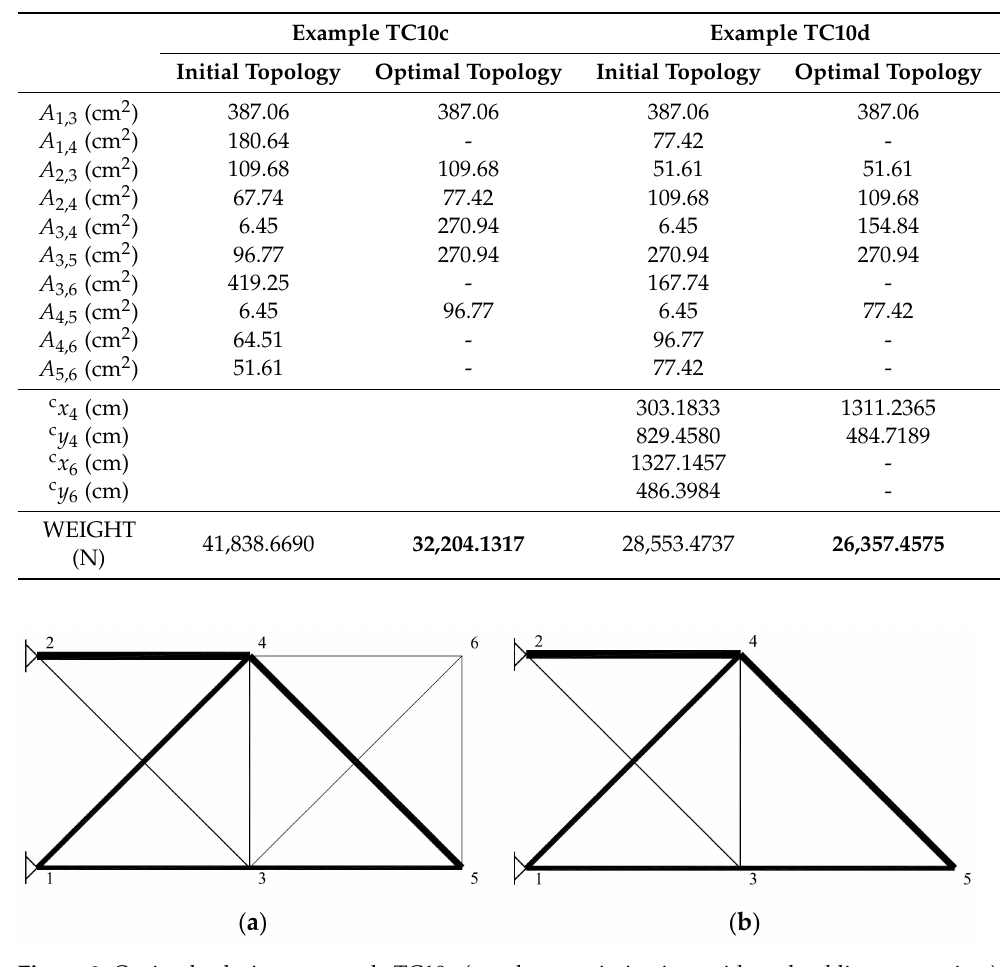
Figure 9. Optimal solutions, example TC10a (topology optimization, without buckling constraints). ( a ) Initial topology; ( b ) optimal topology.